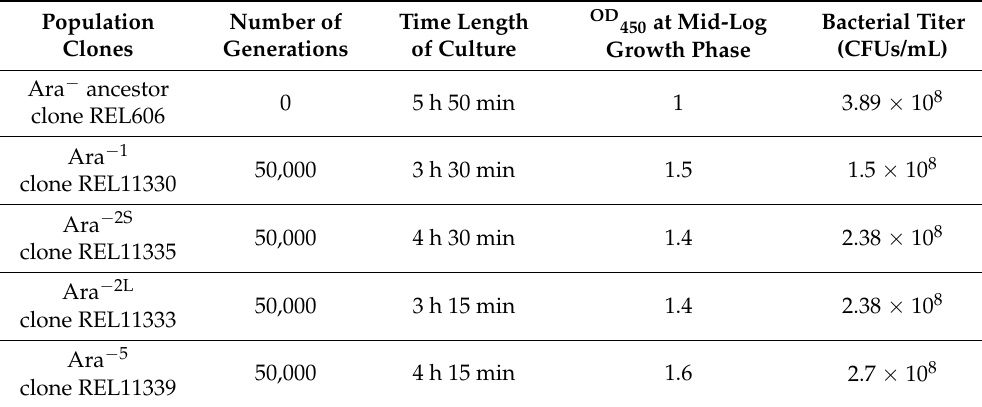
Table 1. LTEE bacterial clones used in this study. The table indicates the population they originated from, the evolutionary time they were isolated and the time at which pure cultures in DM1000 were stopped before OMVs isolation with the corresponding mid-log growth phase optical density (OD) at 450 nm, and their bacterial titer in colony-forming units per milliliter. OD Bacterial Titer Population Number of Time Length 450 at Mid-Log (CFUs/mL) Clones Generations of Culture Growth Phase Ara − ancestor clone REL606